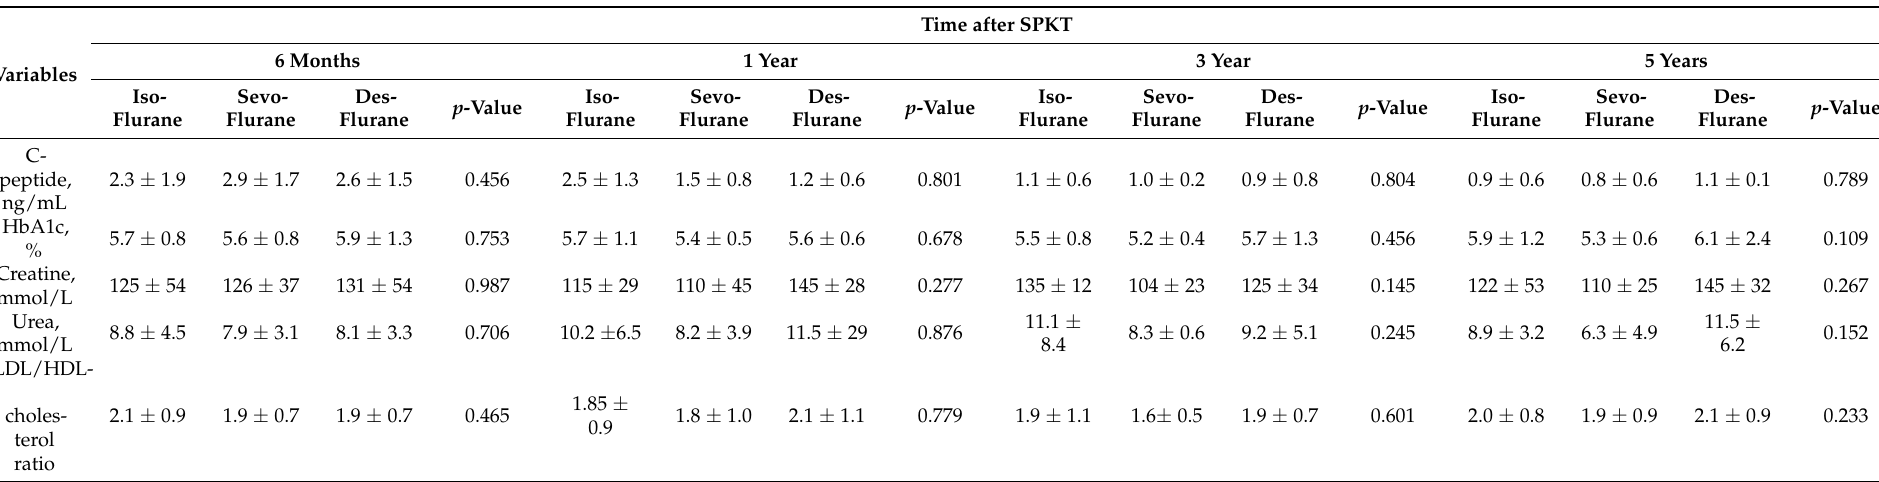
Table 4. Metabolic outcome after simultaneous pancreas–kidney transplantation stratified by the primary inhaled anesthetic agent (isoflurane, sevoflurane, desflurane).